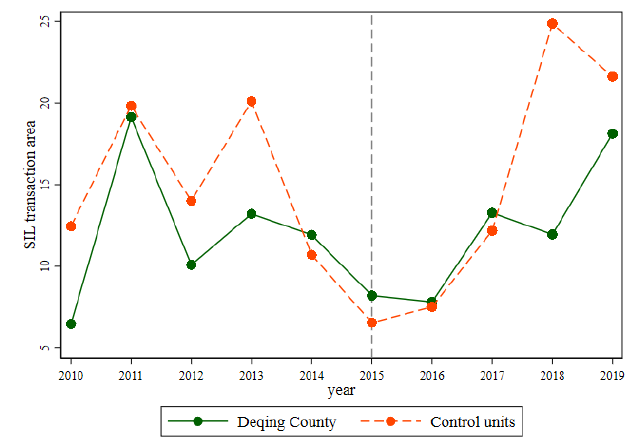
Figure 3. Trend of the SIL transaction area in Deqing County and Counties without COCLEM from 2010 to 2019.